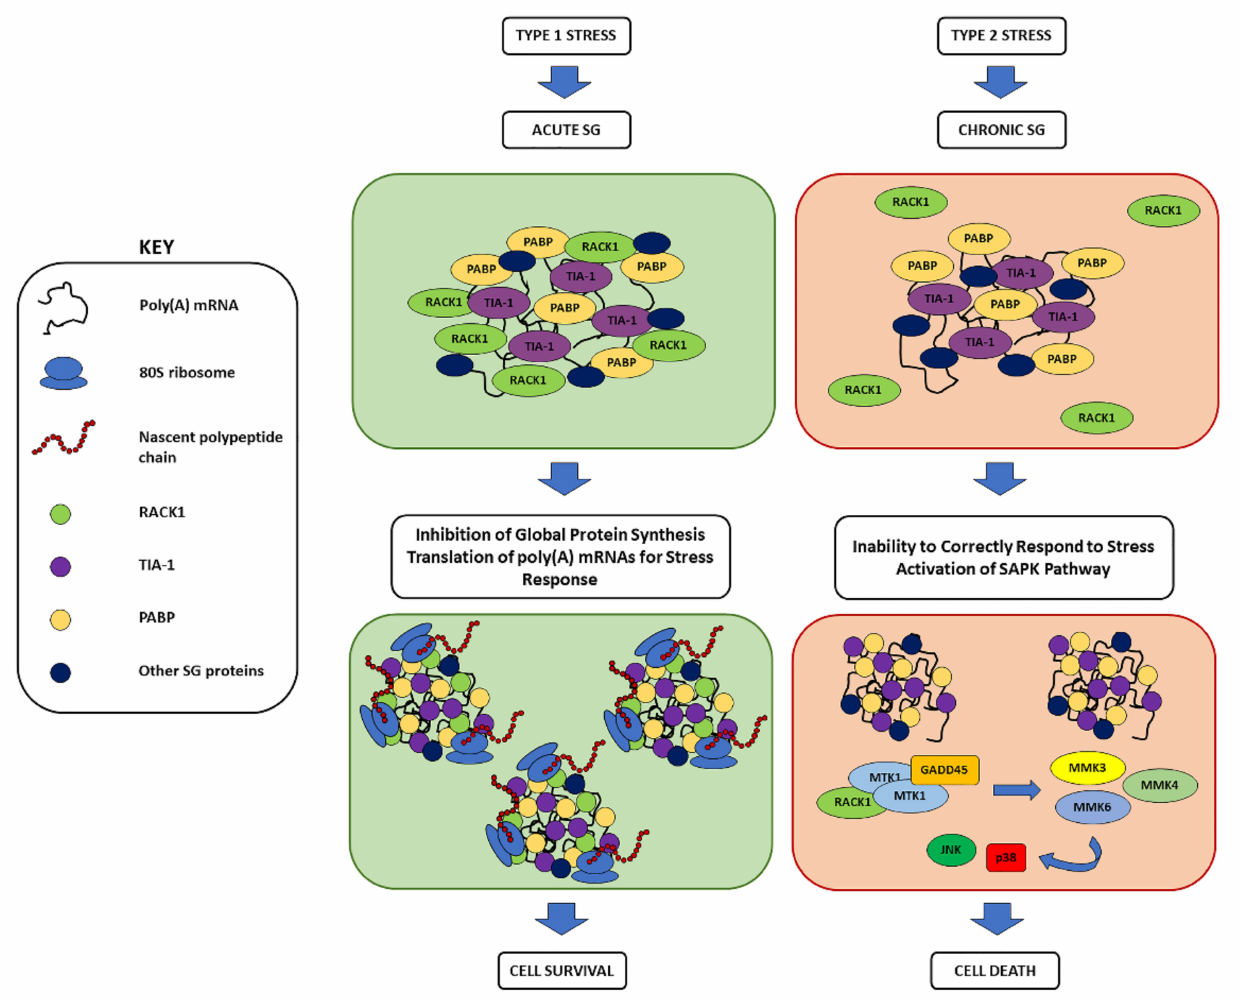
Figure 4. Role of RACK1 in acute and chronic SGs. Together with TIA1 (in violet), PABP (in yellow), and other SG-related RBPs (in dark blue), RACK1 (in green) has been recognised as a ribosomal protein recruited in SG formation. While included within acute SGs produced after type 1 stress promoting cell survival, RACK1 is excluded in chronic SGs after type 2 stress and remains in the cytoplasm, where it can activate the SAPK cascade, leading to JNK and p38 MAPK activation, which results in cell death (see text for